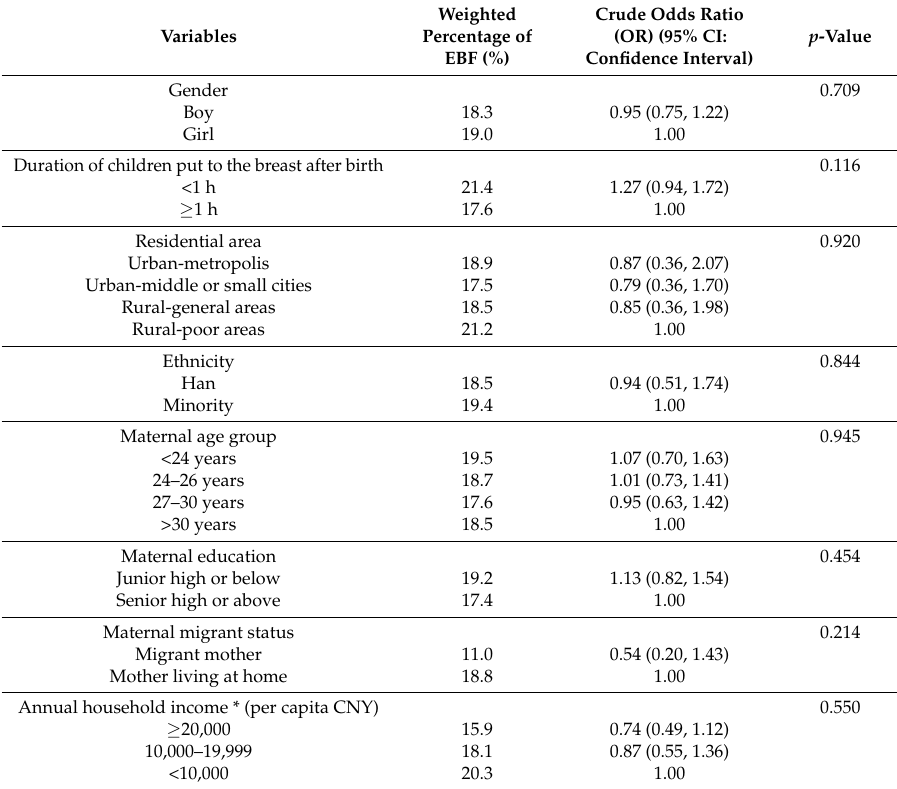
Table 2. Determinants of exclusive breastfeeding (EBF) rate for children aged 0–5